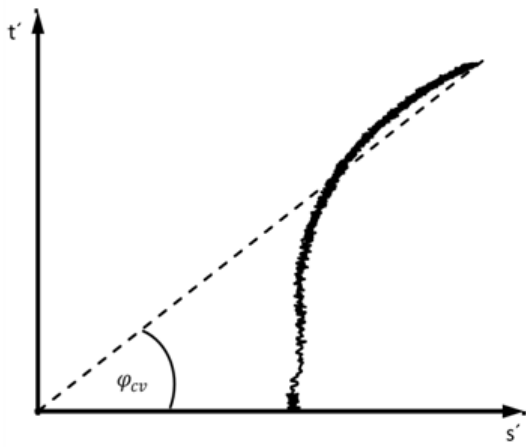
0 × s 0 space c in the t